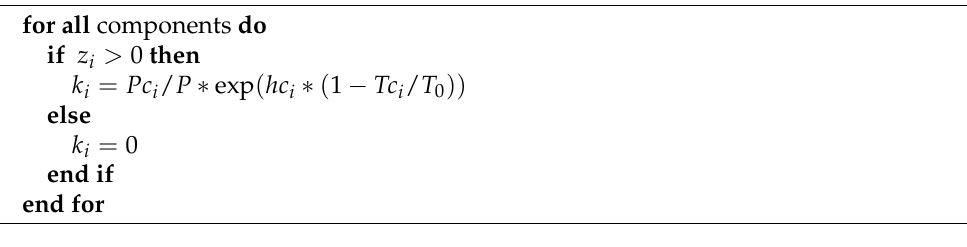
Figure 10. The data structure of the thermodynamic property. ( a ) Array of structures. ( b ) Structure of arrays. Algorithm 2 Original pseudocode for solving flashing problems